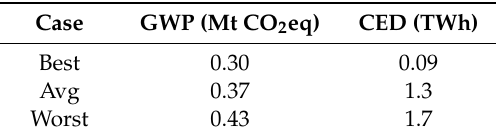
Figure 4. Calculation of greenhouse gas (GHG) emissions (lines) and reduction compared to 2020 (bars) for biologics manufacturing in Germany. Three process improvement scenarios are considered: red = worst case (low impact and slow industrialization); orange = realistic (impact as discussed, normal industrialization time) and green = best case (highest impact and fast industrialization).